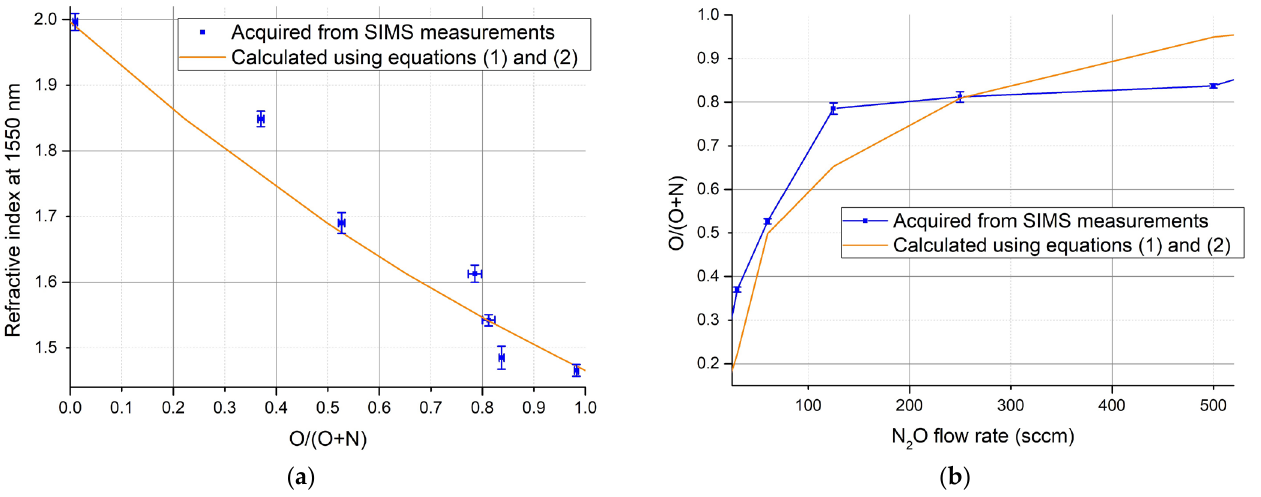
Figure 5. ( a ) Dependence of refractive index at 1550 nm on the O/(O + N) concentration ratio; ( b ) the O/(O + N) concentration ratio of SiON films as a function of the N 2 O flow rate.